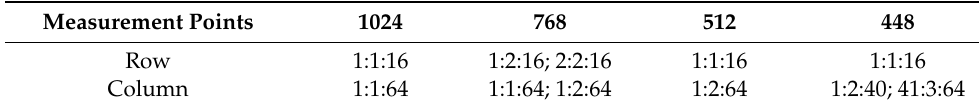
Table 1. Locations of measurement points (elements).